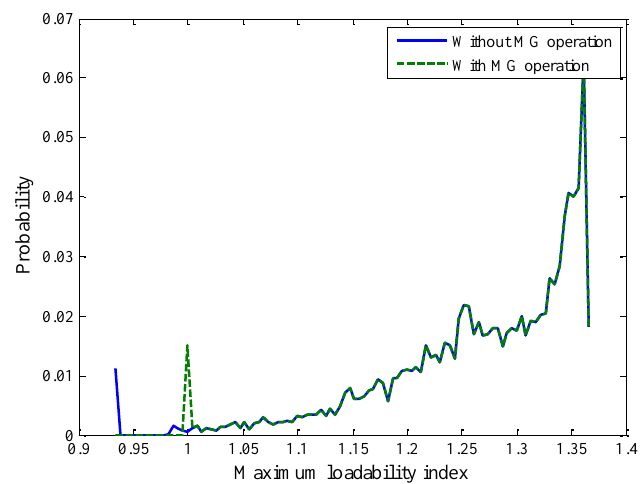
Figure 15. Probability distribution of MLI.